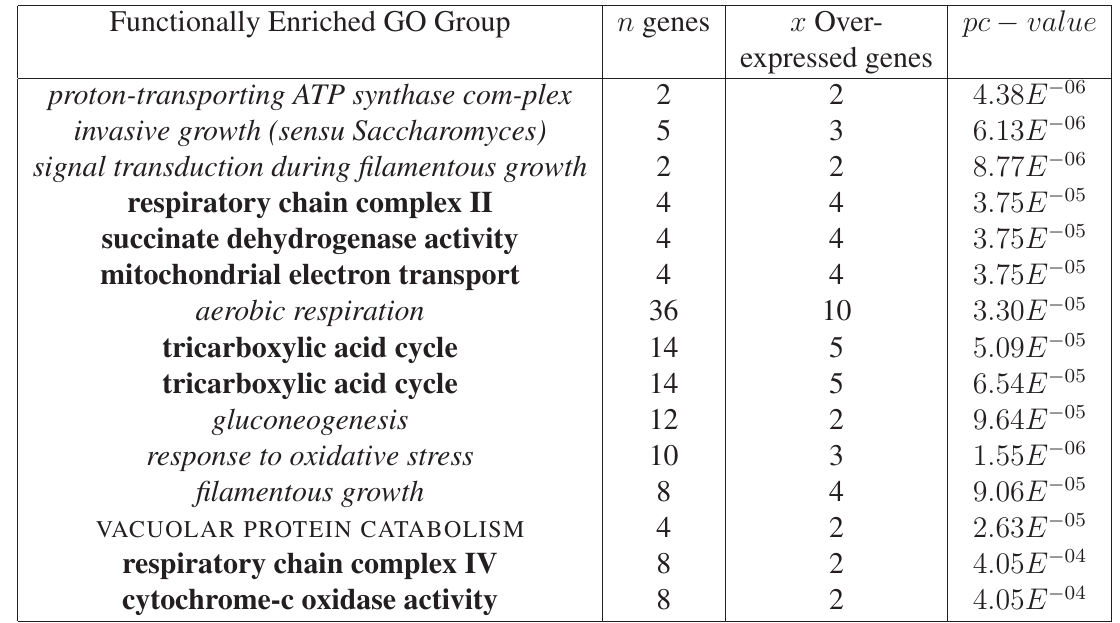
Table 2: Over-Expressed FEGs obtained by CGGA with a p − value = 6 . 88 E −